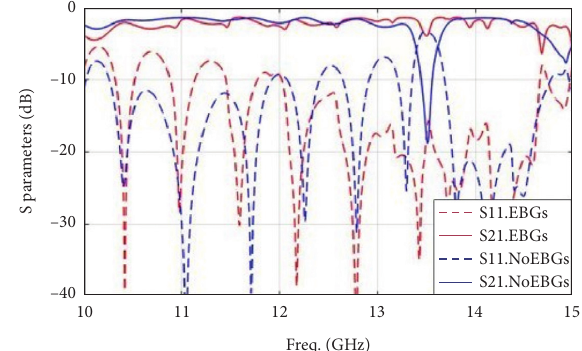
Figure 10: Comparison of the simulated reflection and trans- mission parameters of the waveguide realized with the EBG units and the original dielectric